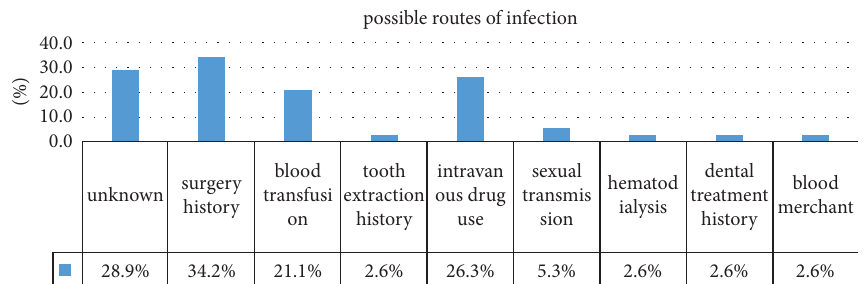
Figure 2: Possible routes of